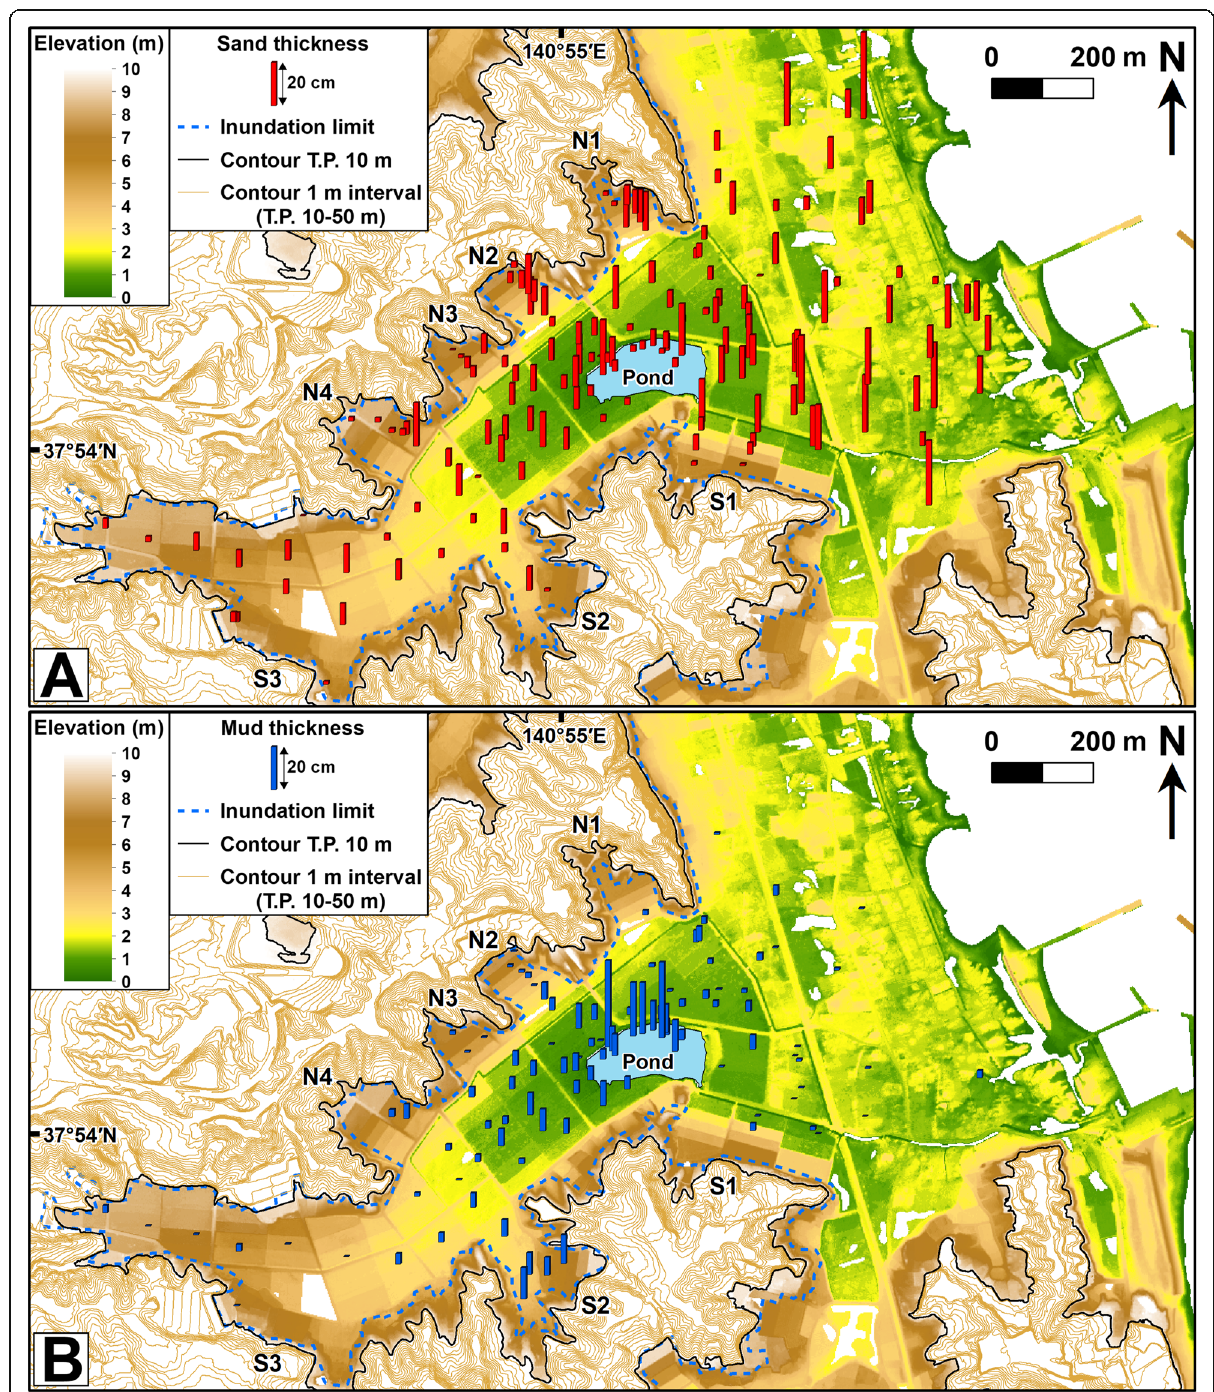
Fig. 3 Spatial thickness distribution of a tsunami sand and b tsunami mud. Elevation map and contour line are based on the 2 m grid DEM data provided by GSI. N, north sub-valley; S, south